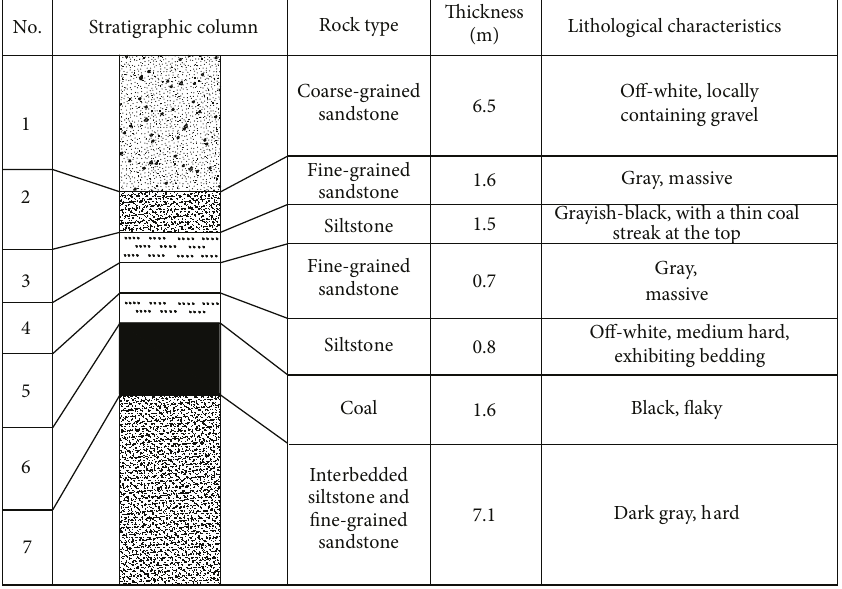
Figure 6: Composite stratigraphic